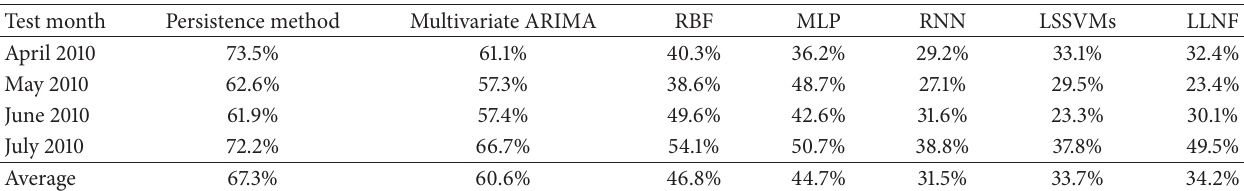
Table 5: RMSE improvement ∗ achieved by the proposed LLNF method with respect to the compared approaches. Test